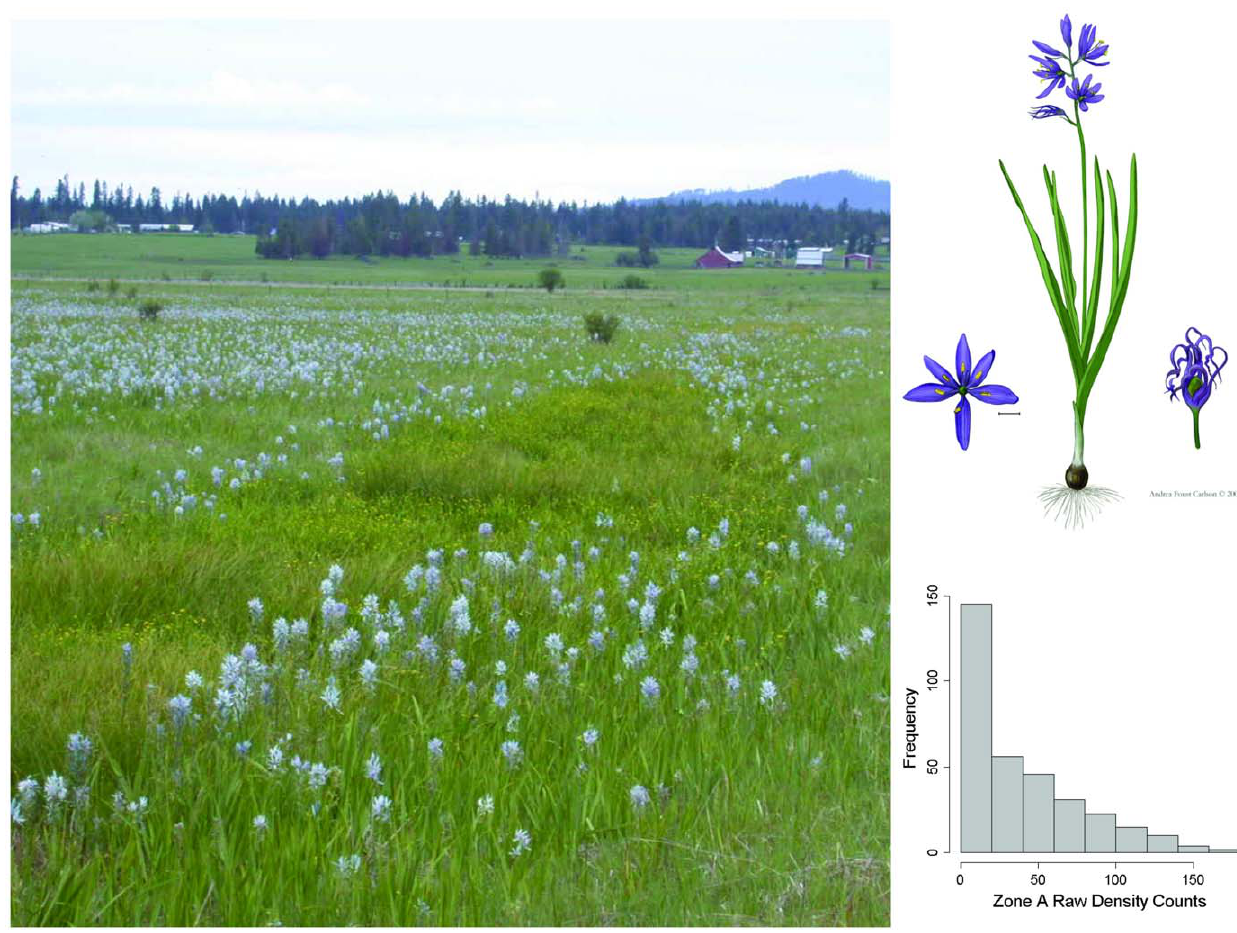
Figure 1. A photograph of camas growing in the restoration study site, Weippe Prairie, Idaho, USA. Camas is a bulb-forming geophyte (upper inset) with limited dispersal capabilities. This attribute and its propensity for prairie swales that experience longer periods of inundation and elevated soil moisture during the growing season creates dense but patchily distributed colonies, as illustrated here. This patchy distribution also leads to highly skewed density counts (lower inset). Upper inset illustration by Andrea Foust Carlson, reproduced with permission. Photo courtesy of the National Park Service.